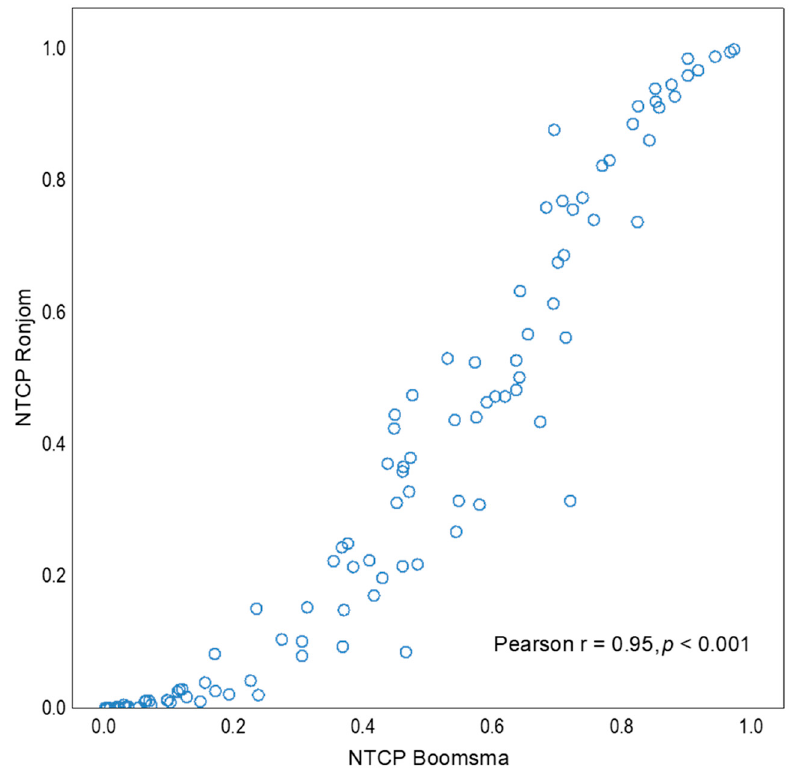
Figure 1. Relationship between normal-tissue complication probability (NTCP) scores predicted by